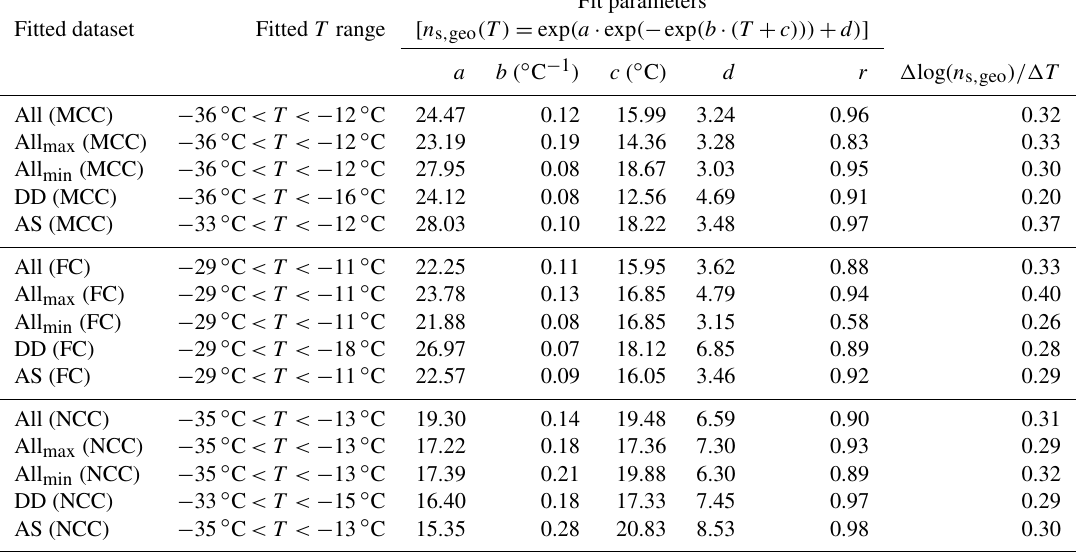
Table 3. List of the Gumbel cumulative distribution fit parameters to the n s , geo (T ) for T -binned ensemble datasets of MCC, FC and NCC (All). The datasets are fitted in the log space. In addition to all, fit parameters for ensemble maximum values (All max ) , ensemble minimum values (All min ) , suspension subset (AS) and the dry-dispersed particle subset (DD) are also included in this table. The correlation coefficient, r , for each fit is also shown. All n s , geo (T ) values are per square meter. T is in degrees